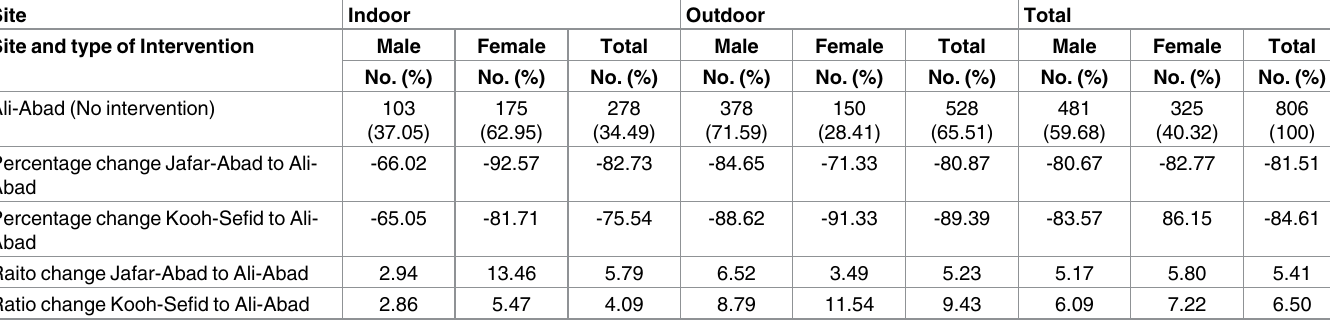
Table 9. The comparison of P . papatasi frequency indoors and outdoors in Jafar-Abad(plants, bushes, and shrubs sprayed with ATSB) and Kooh-Sefid (ATBS-treated barrier fences) with Ali-Abad (no intervention) using light traps, Markazi district, Qom province, 2015. Site Indoor Outdoor Total Site and type of Intervention Male Female Total Male